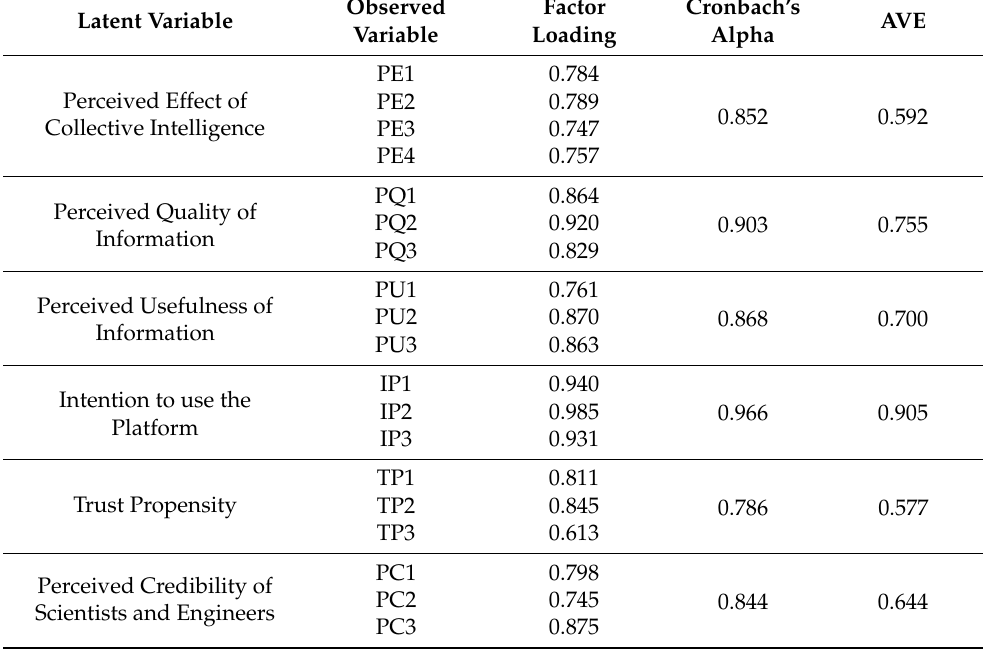
Table 2. The results for reliability analysis and convergent validity analysis.